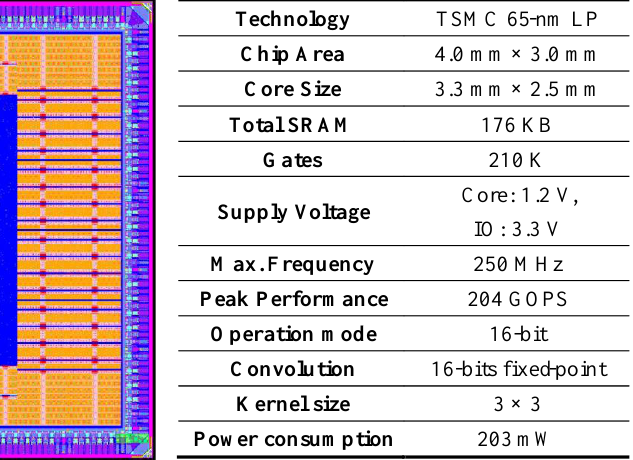
Figure 10. ASIC layout and specifications.